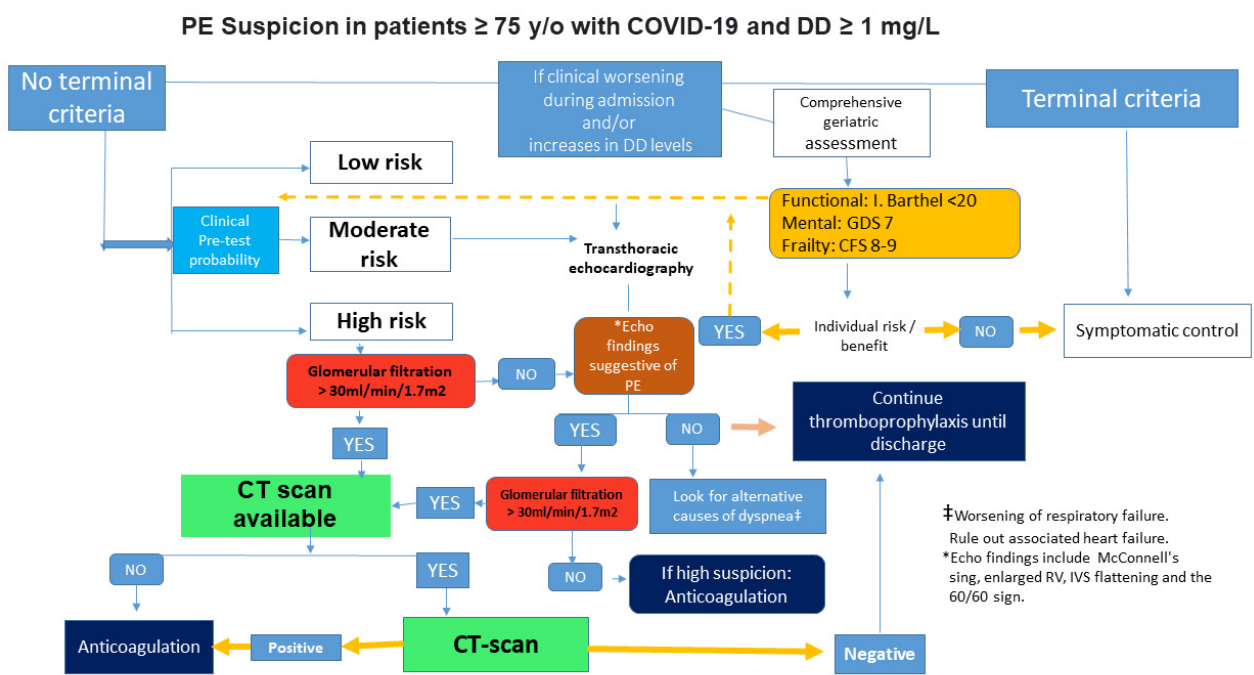
Figure 1. Algorithm for pulmonary embolism in elderly patients with COVID-19. High-risk patients were considered those who scored >6 on the Wells scale or >11 on the revised Geneva scale, and those with D-dimer ≥ 1 mg/L with a torpid evolution; RV—Right ventricle; IVS—Interventricular septum; GDS—Global deterioration scale; CFS—Clinical frailty scale.